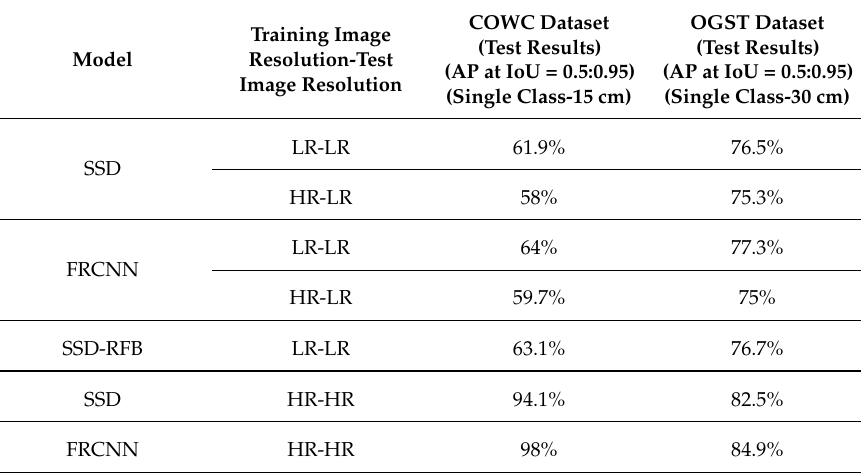
Table 1. Detection on LR (low-resolution) and HR (high-resolution) images without using super-resolution. Detectors are trained with both LR and HR images and AP (average precision) values are calculated using 10 different IoUs (intersection over union).